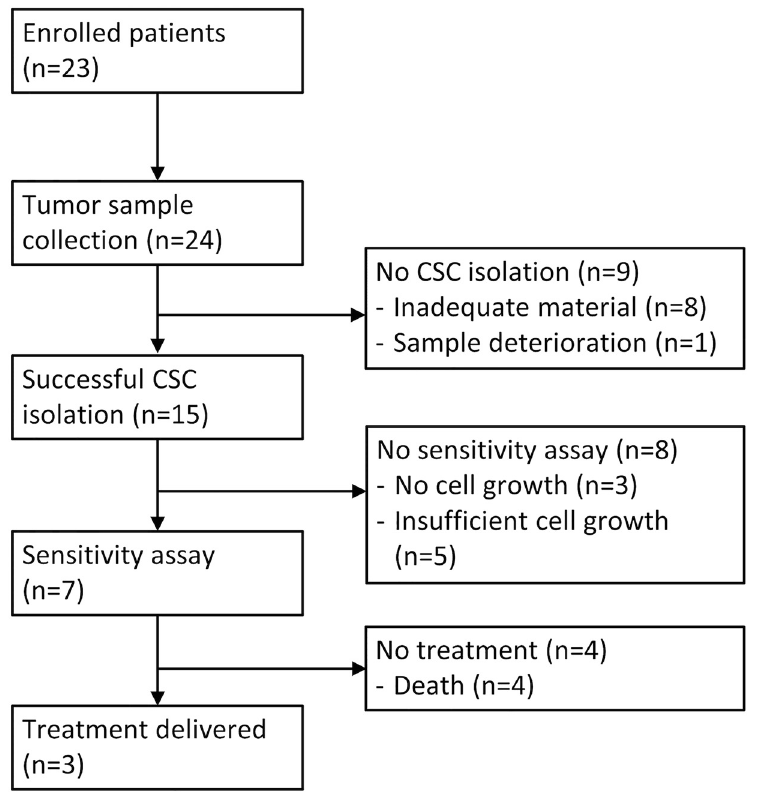
Fig 1. Flow chart of the